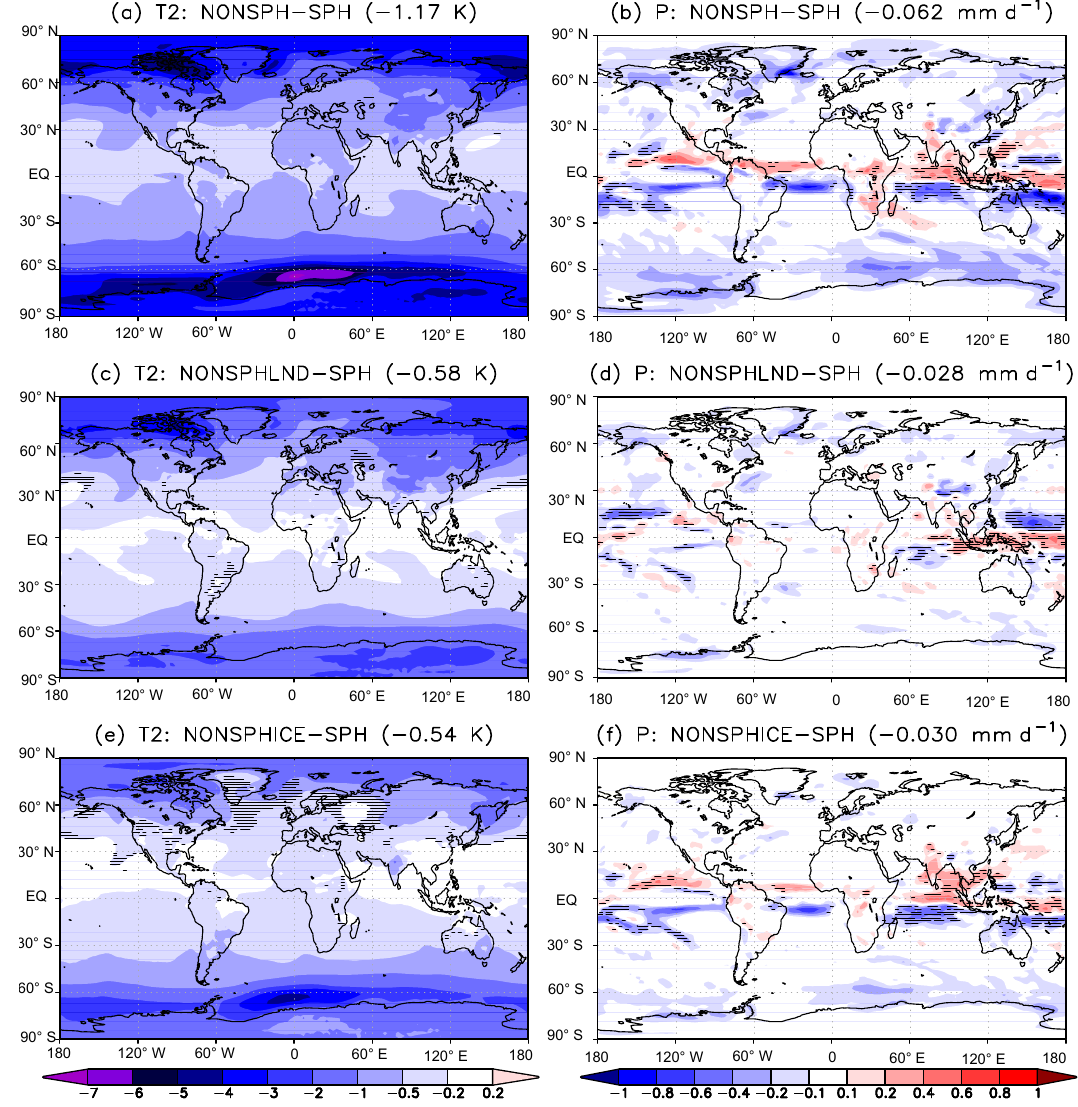
Figure 3. Annual-mean differences in (a) 2m air temperature and (b) in precipitation between the NONSPH and SPH experiments, (c– d) between the NONSPHLND and SPH experiments, and (e–f) between the NONSPHICE and SPH experiments. Global mean differences are given in the panel titles. Hatching indicates differences that exceed the threshold for colour shading (0.2K for temperature and 0.1mmd − 1 for precipitation) but are not significant at the 5%